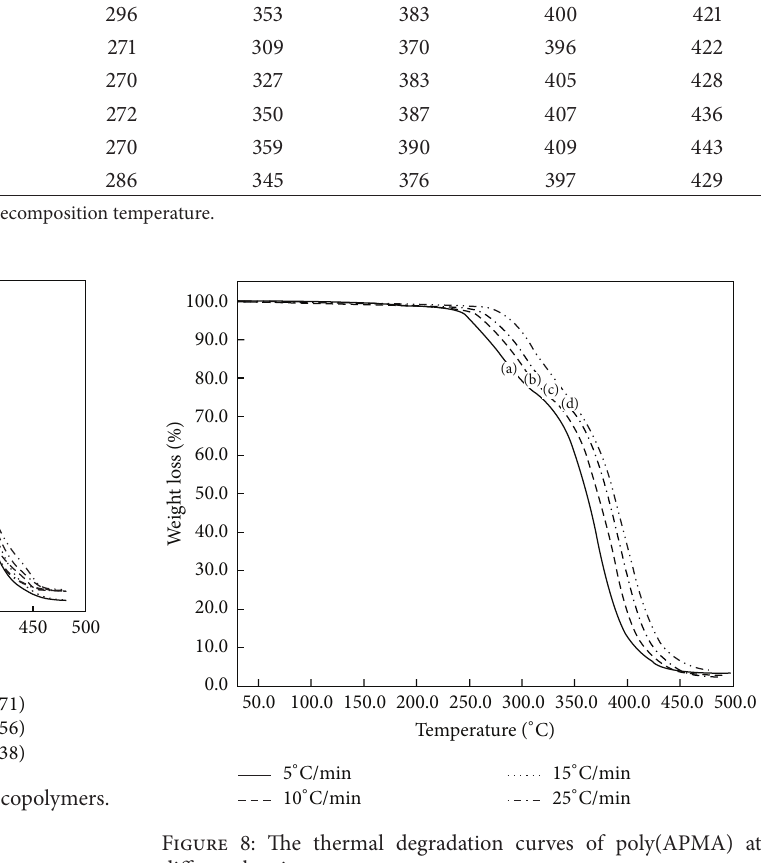
Table 5: Thermal behaviour and decomposition temperatures of the copolymers and homopolymers. Polymer